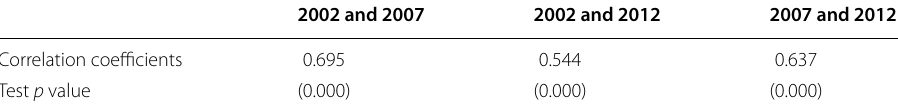
Table 7 Correlations between data quality of individual sectors in different years